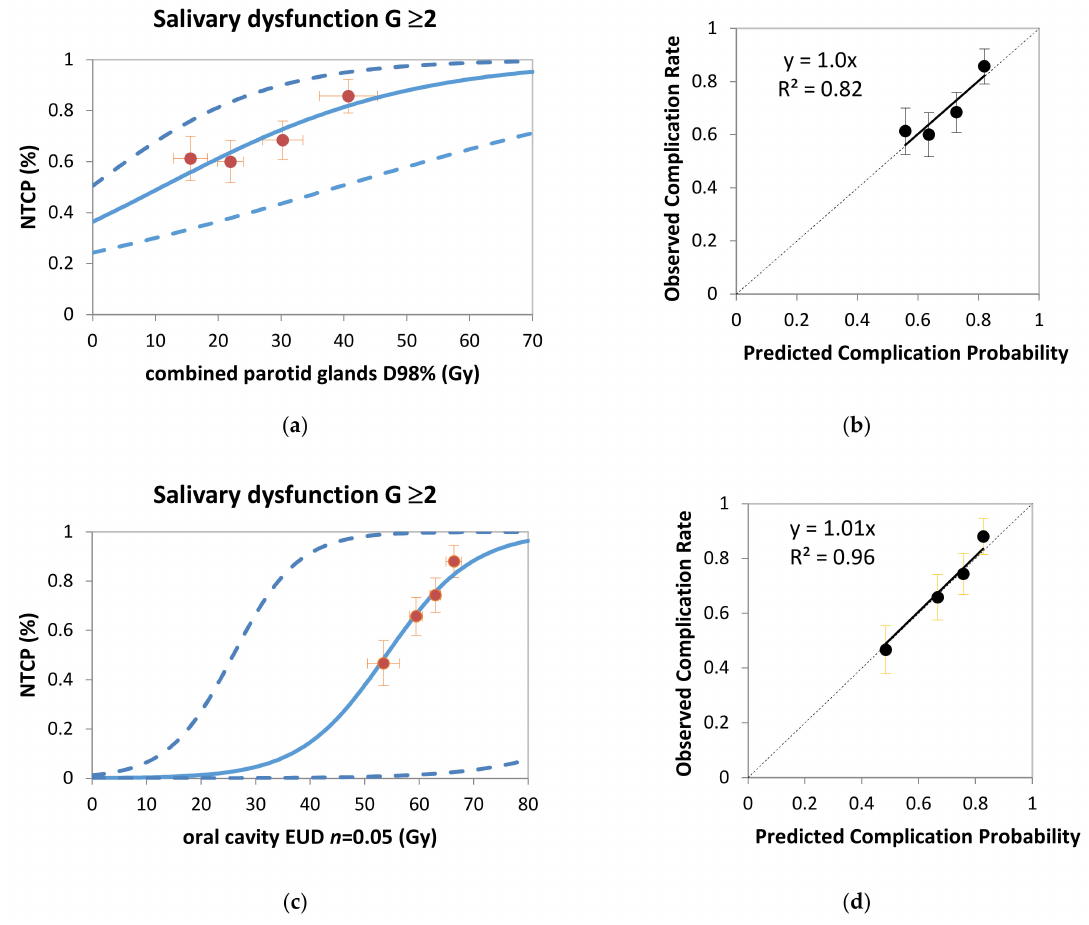
Figure A3. Probability of grade ≥ 2 acute salivary dysfunction as a function of D98% of combined parotid glands (panel ( a )) and oral cavity Equivalent Uniform Dose (EUD) calculated with n = 0.05 (panel ( c )). Observed complication rates (solid circles) and the predicted complication probability curve (continuous line) are plotted. The dotted lines identify the 68% confidence intervals for the predicted curve. Calibration plots for the predictive models for grade ≥ 2 acute salivary dysfunction: for the model including combined parotid glands D98% (panel ( b )) and for the model including oral cavity EUD (panel ( d )). The solid lines represent the calibration graphs of the models and the black points are the observed complication rates together with their standard deviation. The dashed line represents the identity line. The calibration equation together with the corresponding R 2 are presented on the calibration plots. Table A1. Results of the univariate logistic regression analysis with acute salivary dysfunction grade ≥ 2 as primary endpoint. Age was divided in five year intervals; Body Mass Index (BMI) was considered as a continuous variable and as a dichotomous one, with cutoff values set at 25.0 kg/m 2 and 30.0 kg/m 2 according to WHO definition of overweight and obese, respectively; histology was grouped into undifferentiated versus Squamous Cell Carcinoma (SCC); stage was dichotomised in ‘low-intermediate’ if I, II, III and ‘high’ if IVA or IVB; T stage was considered as ‘low-intermediate’ if 1, 2, 3 and ‘high’ if 4. Nodal status is 0 if N0 or N1, 1 if N2, N3a or N3b. Variable Coefficient SE p -Value OR 95% CI Gender = Male vs.